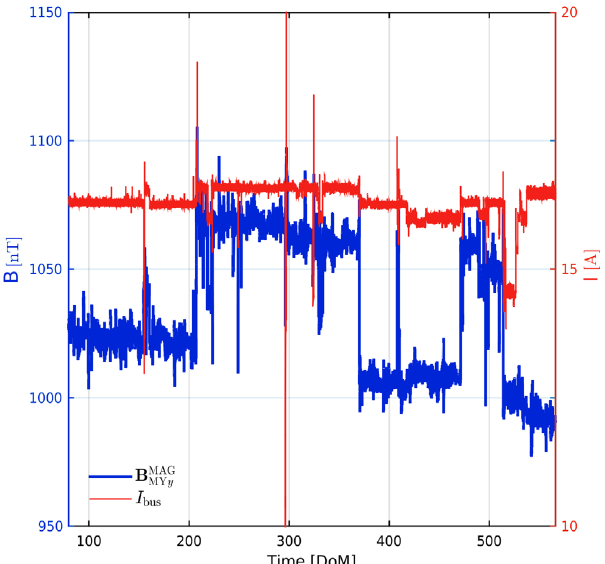
Figure 4. LPF main bus current ( I bus ), solar array bus current ( I sar ), and auxiliary power supply A current ( I aux;A ) during the LPF mission operations from February 16, 2016, through June 30, 2017. At DoM near 300, an isolated overload is observed. Data in the corresponding interval of time have not been included in this analysis.